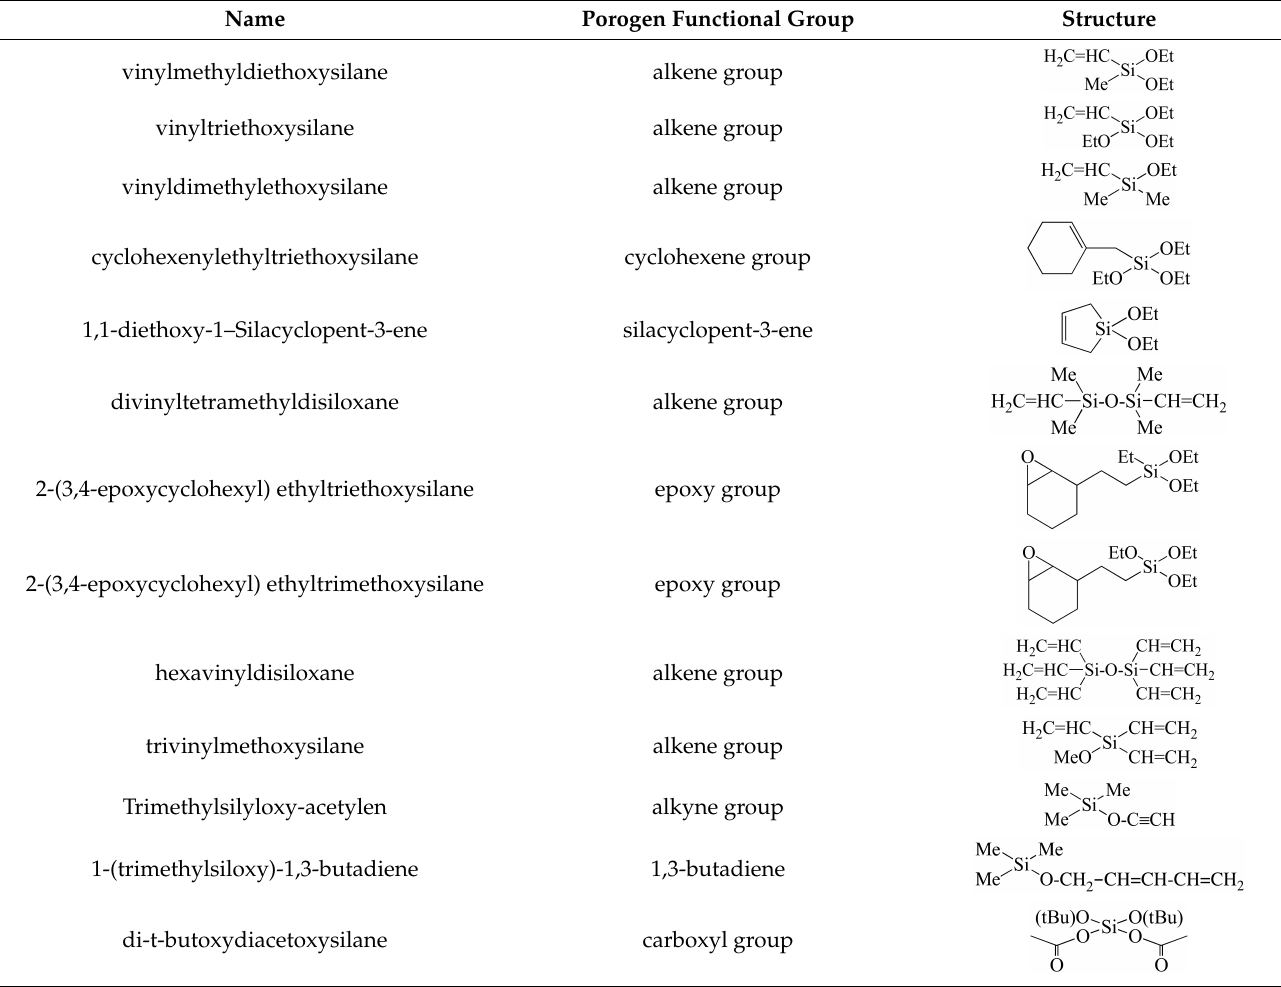
Table 4. SiCOH precursors with embedded porogen organic